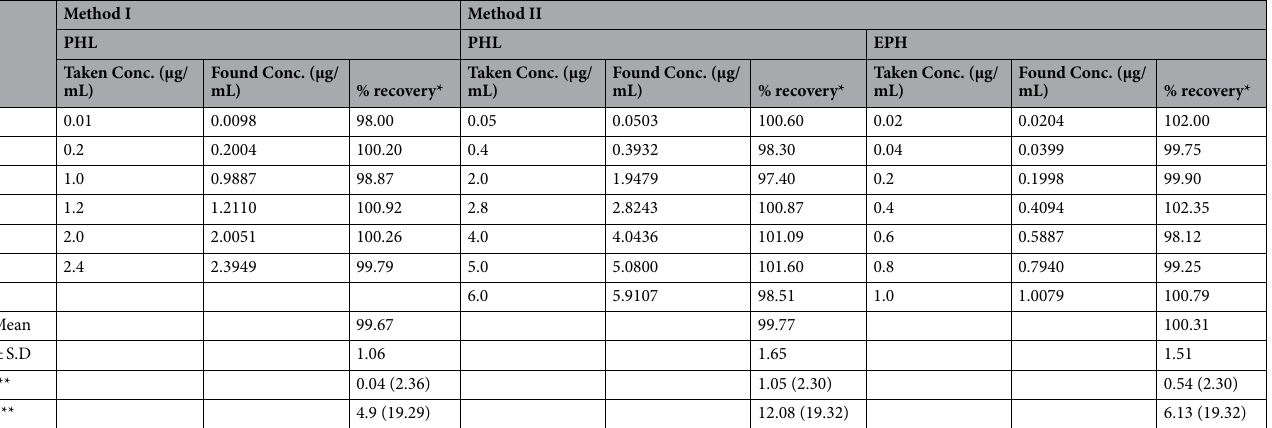
Table 2. Accuracy data for the proposed methods. *Each result is average of 3 separate determinations. **Values between parentheses are the tabulated values of t-test and F-test at p = 0.05 50